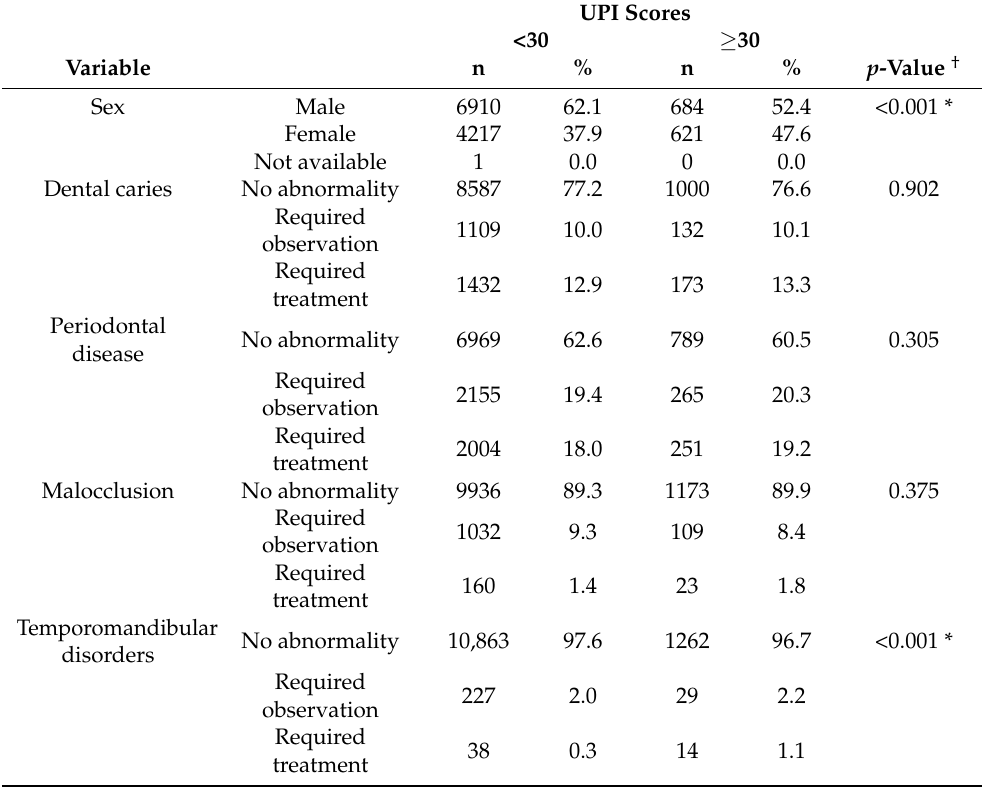
Table 1. Participants’ characteristics of dental health status stratified according to UPI scores.